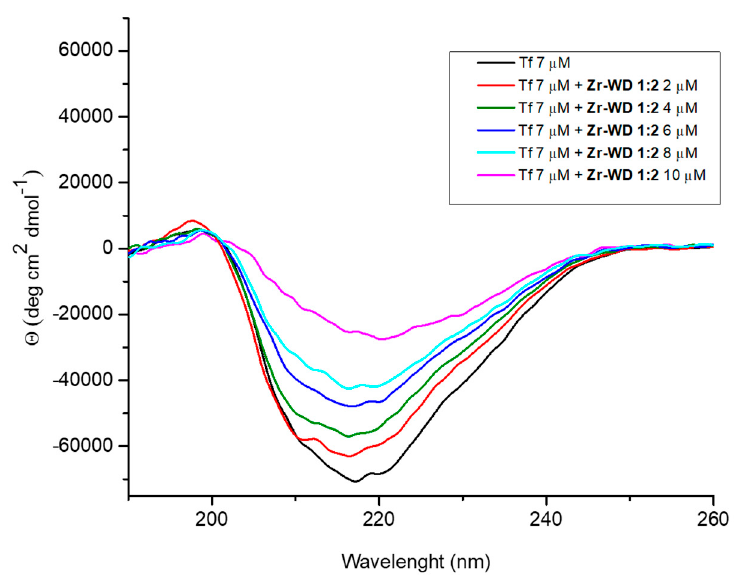
Figure 6. CD spectra of transferrin (7 µM) in phosphate buffer (10 mM, pH 7.4) with increasing concentrations (0–10 µM) of Zr-WD 1:2 .